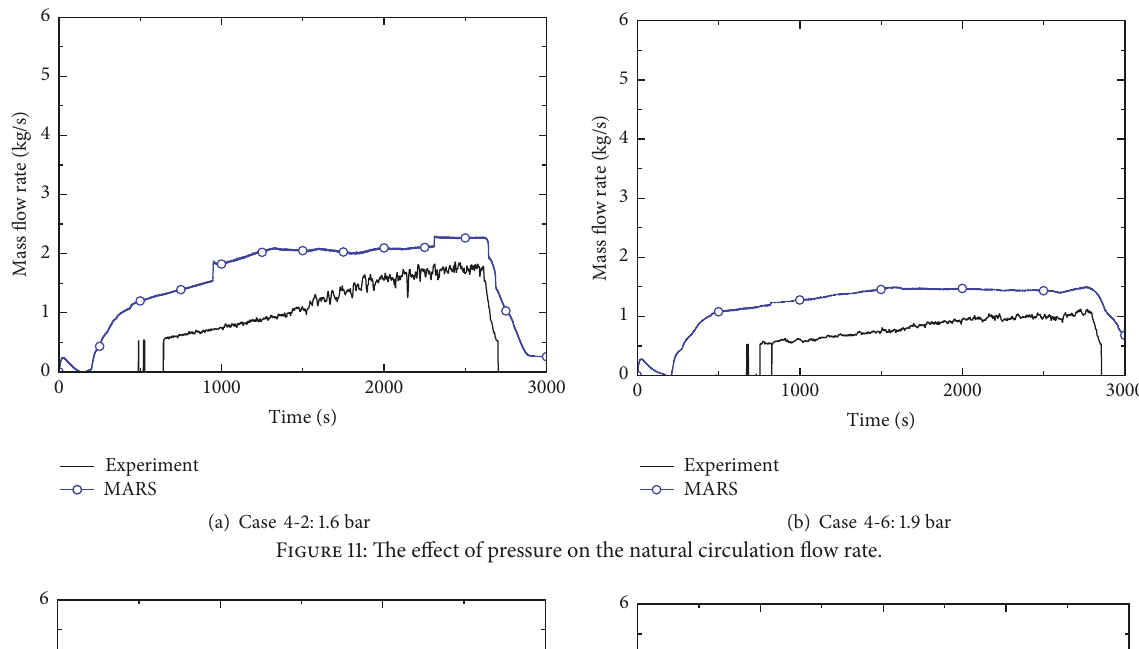
Figure 11: The effect of pressure on the natural circulation flow rate.